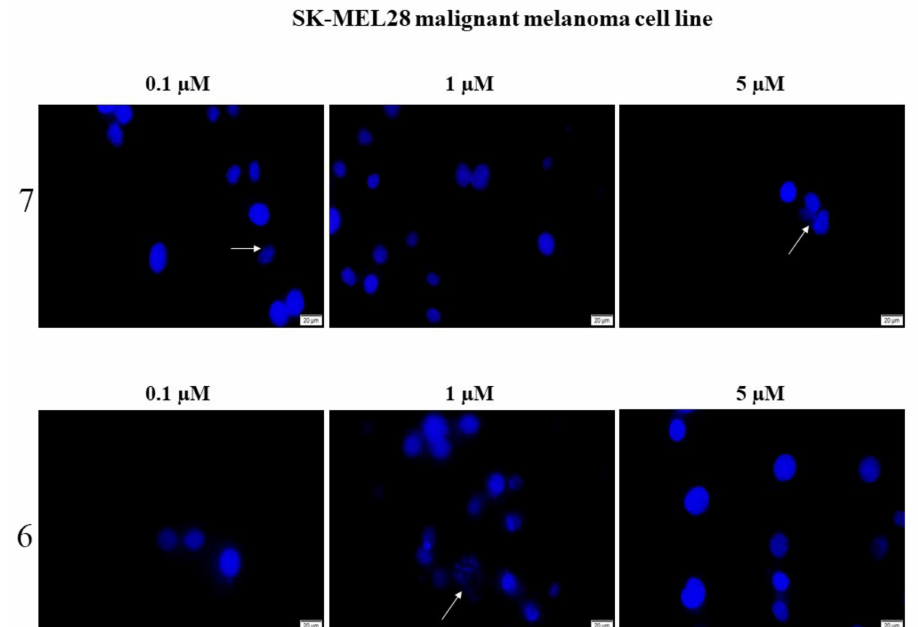
Figure 8. Effect of compounds 6 and 7 (0.1, 1, and 5 uM) and DMSO (0.1, 1, and 5 uM) after 24 h of stimulation on the SK-Mel-28—DAPI staining. The white arrows indicate the apoptotic cells with nuclear fragmentation; figures are scaled at 20 µ m.